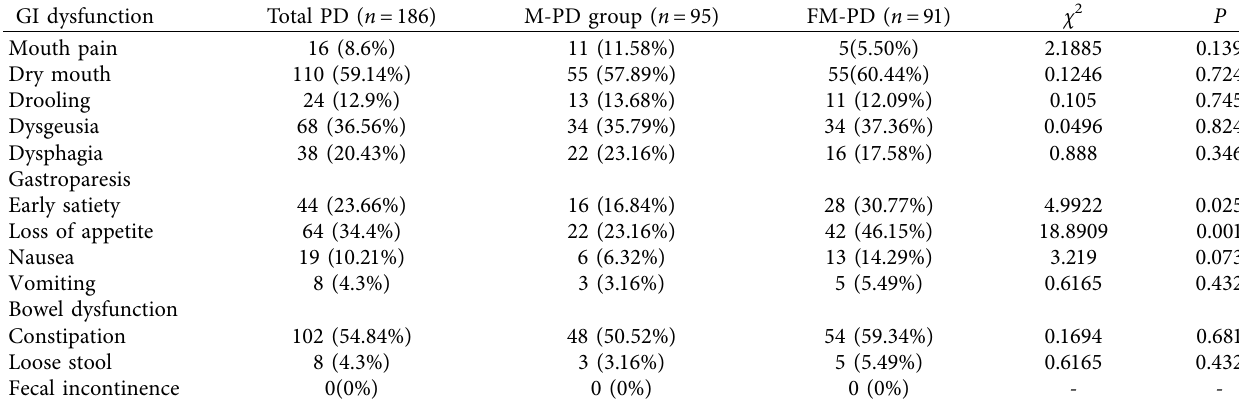
Table 2: GI dysfunctions in M-PD and FM-PD group (%).